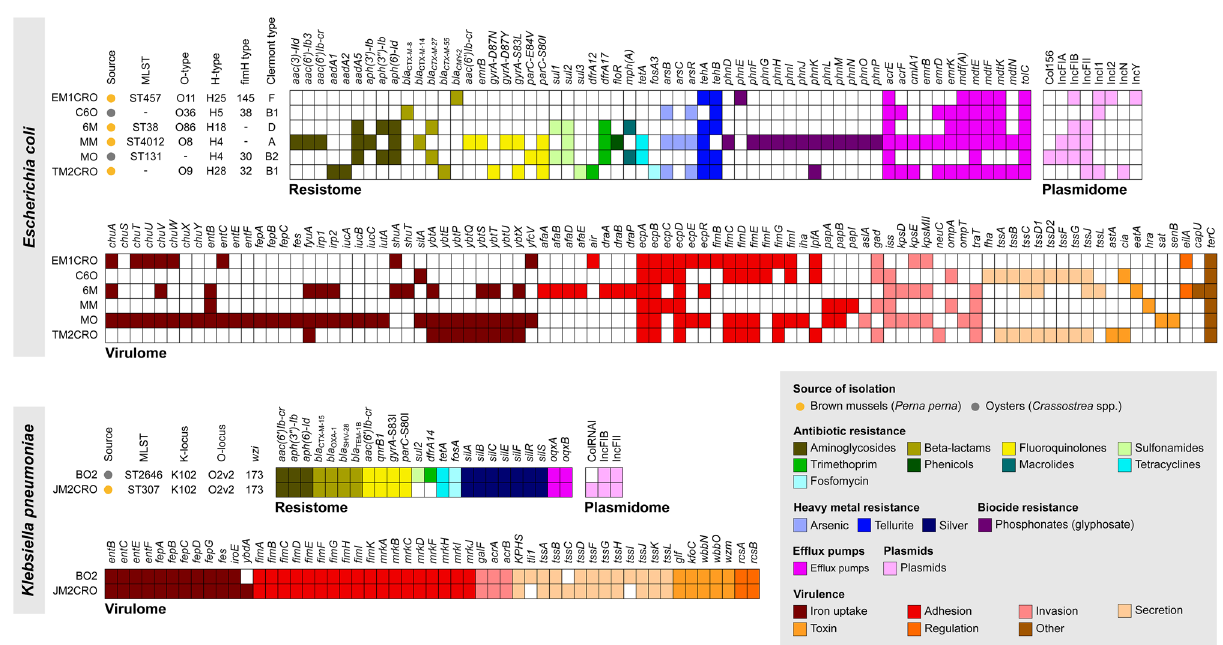
Figure 2. Heatmap of virulome, resistome, plasmidome, MLST and serotype of critical priority WHO Enterobacterales isolated from wild edible marine bivalves recovered from anthropogenically-polluted area on the South America Atlantic